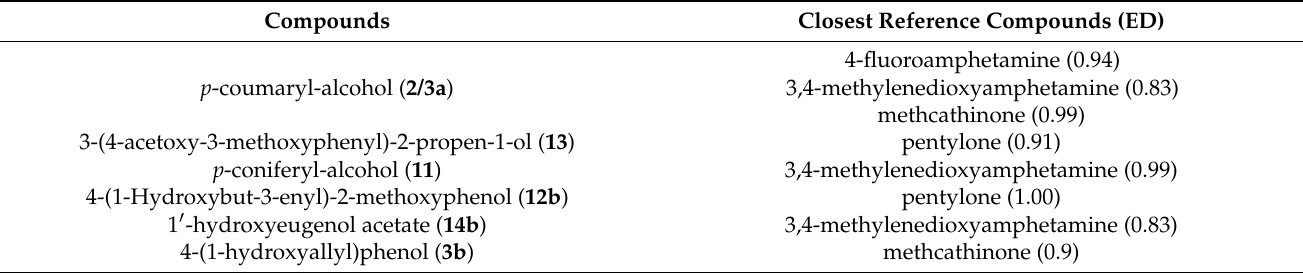
Table 2. Reference compounds and their Euclidean distances (ED) closest to galangal components. Compounds Closest Reference Compounds